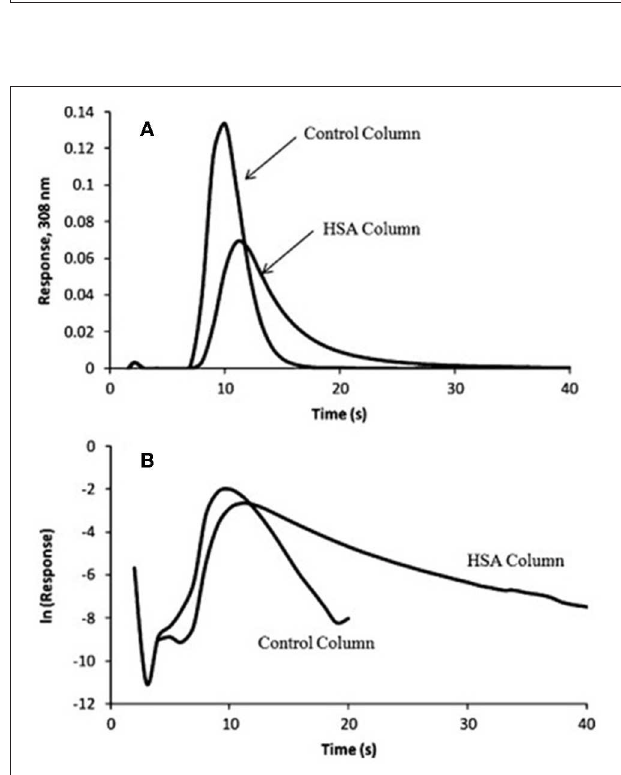
FIGURE 7 | (A) Elution profile and (B) natural logarithm of the elution profile obtained for the application of a 100 µ L sample of 10 µ M racemic warfarin onto a control monolith column and an HSA monolith column and by using the peak decay method for data analysis. Reproduced with permission from Yoo and Hage (2011b) . Copyright 2011